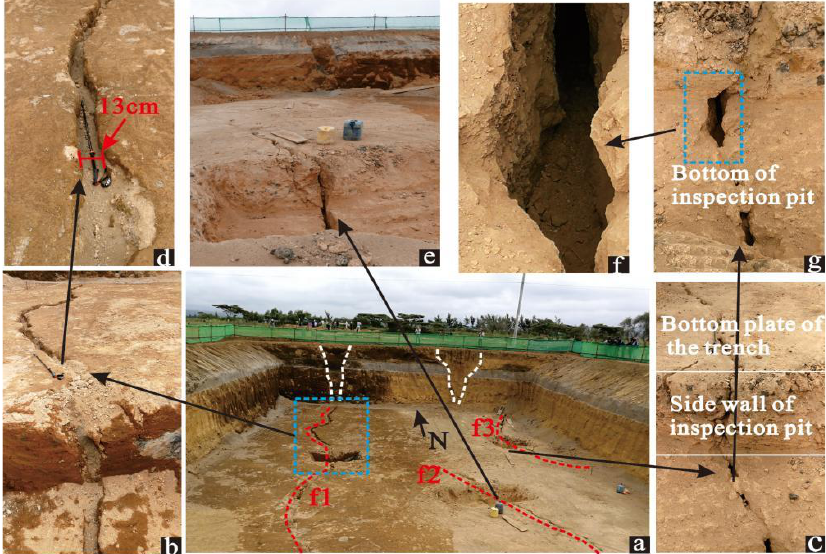
Figure 12. Bedrock cracks in Trench 3. ( a ) Overall view of the bedrock cracks; ( b , d ) f1 bedrock crack in detail; ( e ) f2 bedrock crack in detail; ( c , g , f ) f3 bedrock crack in detail. in detail; ( e ) f2 bedrock crack in detail; ( c , g , f ) f3 bedrock crack in